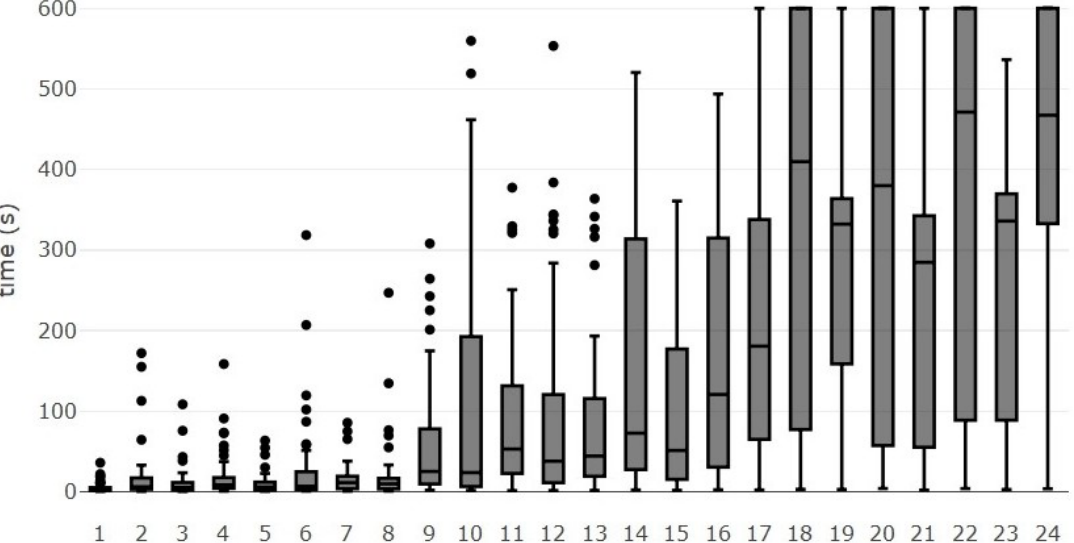
Figure 3. Distribution of the execution time for each case over 50 simulation